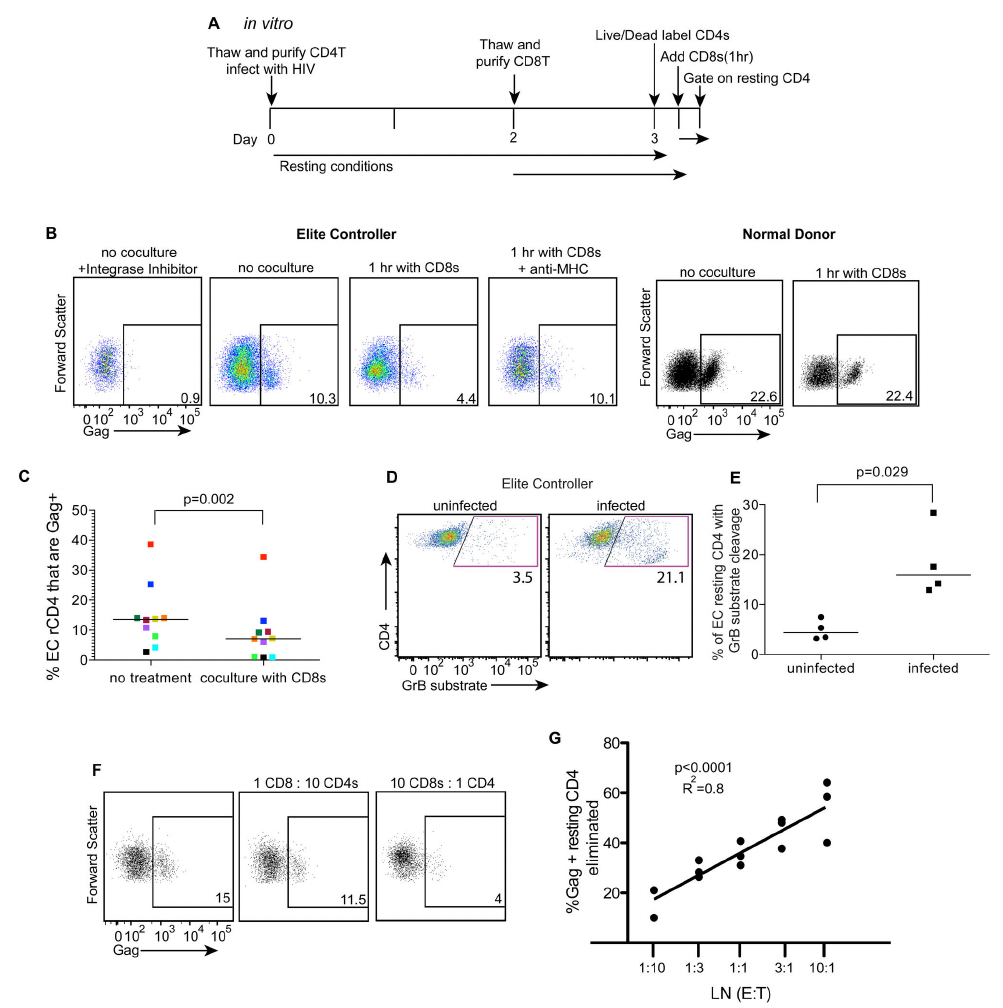
Figure 2. GPR cells from EC can be eliminated by autologous CD8+ T cells. (A) Resting CD4+ T cells were isolated from frozen PBMC and infected as in Figure 1. Autologous CD8+ T cells were purified from a second vial of frozen PBMC by negative bead depletion on day 2 and rested for 24 hours. After labeling the resting CD4+ T cell targets with a viability dye and activation markers, CD8+ T cells and CD4+ T cells were cocultured at a ratio of 10:1 for 1 hour. Cells were then fixed, permeabilized and stained for intracellular Gag and gated on activation marker negative CD4+ T cells for analysis. (B) A representative plot of gated resting CD4+ T cells from an EC or a normal donor that were either cultured alone for 1 hour (no coculture) or cocultured with CD8+ T cells for 1 hour (1hr with CD8s). The same cocultures were treated with an anti-MHC antibody or Raltegravir. The numbers represent the percent of cells that were positive for HIV Gag as above. (C) The percent of GPR cells after 3 days of culture post-infection was compared among samples either cultured alone or cultured with autologous CD8+ T cells for 1 hour (n=10). Lines represent the median and p values were calculated using a Wilcoxon matched-pairs signed rank test. (D) A representative plot of either uninfected or infected EC resting CD4+ T cells after loading with a granzyme B fluorescent substrate and coculture with autologous CD8+ T cells for 1 hour. The values represent the percent of cells positive for cleavage of the granzyme B substrate. (E) Uninfected and infected cells positive for cleavage of the granzyme B substrate were compared (n=4). Lines represent the median and p values were calculated using a Wilcoxon matched-pairs signed rank test. (F) A representative plot of EC resting CD4+ T cells infected with HIV, cultured for 3 days, and either cultured alone or cocultured with autologous CD8+ T cells at a ratio of 10:1 or 1:10 effectors to targets. The values represent the percent of cells positive for HIV Gag. (G) Combination of 3 experiments showing a linear correlation between the percent of infected cells eliminated as calculated by the reduction in HIV Gag positive cells and the natural log of the ratio of effectors to targets at 5 E:T ratios. doi: 10.1371/journal.pone.0071879.g002 PLOS ONE |